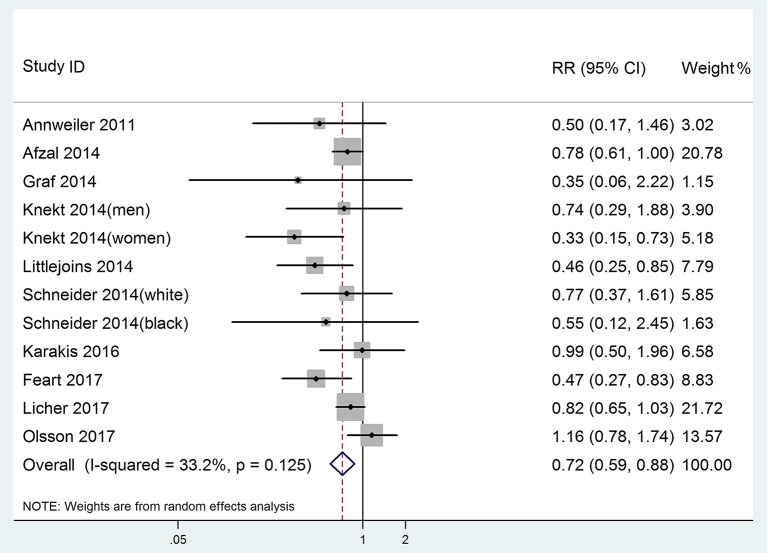
Forest plot of the highest vs. lowest meta-analysis of 25(OH)D level and dementia risk.